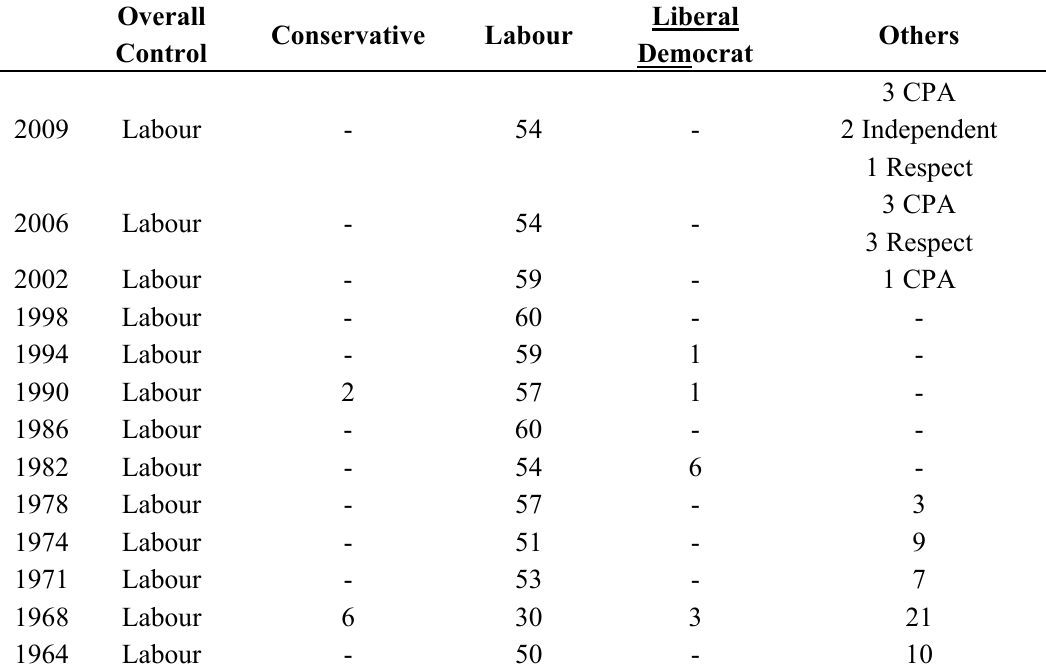
Table 1. Composition of Newham Council,